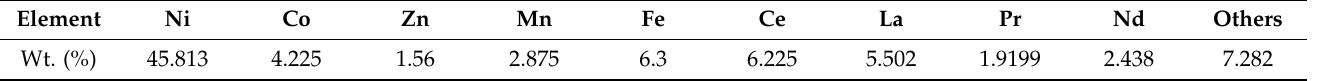
Table 2. Chemical characterization of spent Ni–MH battery